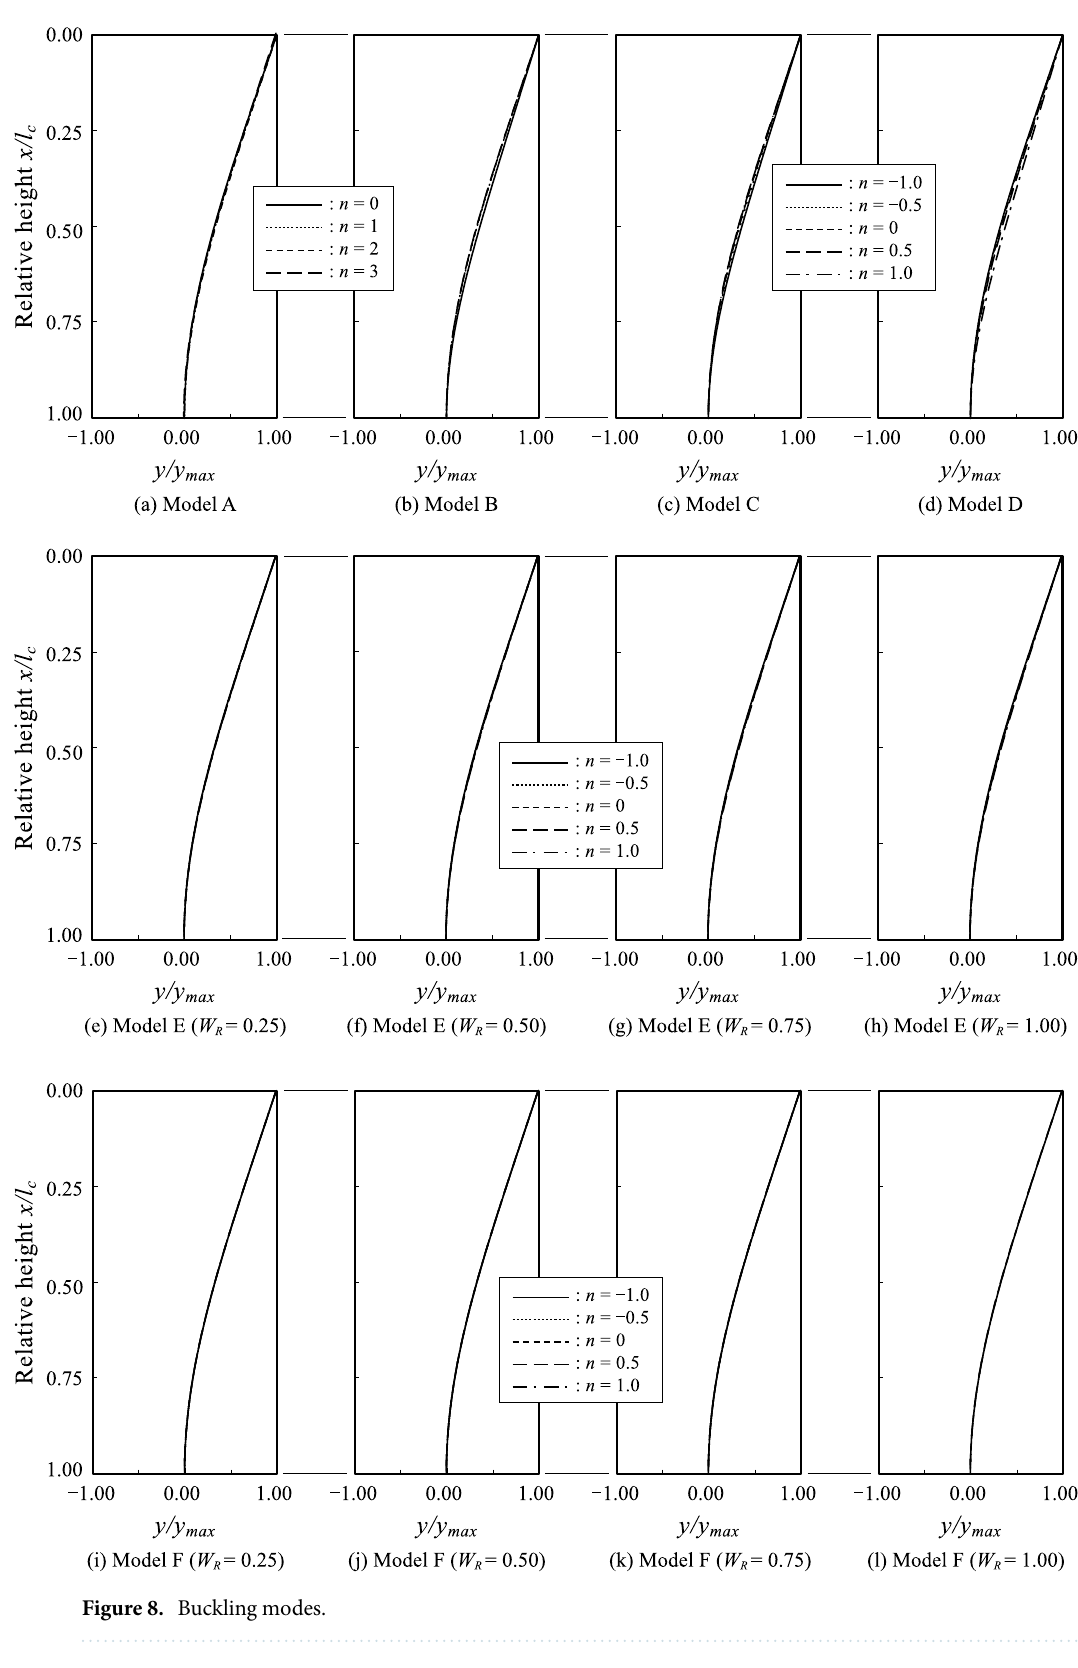
Figure 8. Buckling